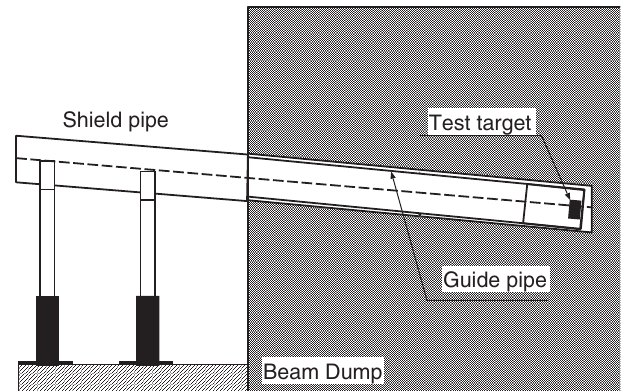
FIG. 2. Schematic view of the basic experimental setup. The test target is inserted into the end of the dump cave. To prevent any radiation pollution during the experiment (loading and unloading the target), a guide pipe is inserted to cover the radiated dump